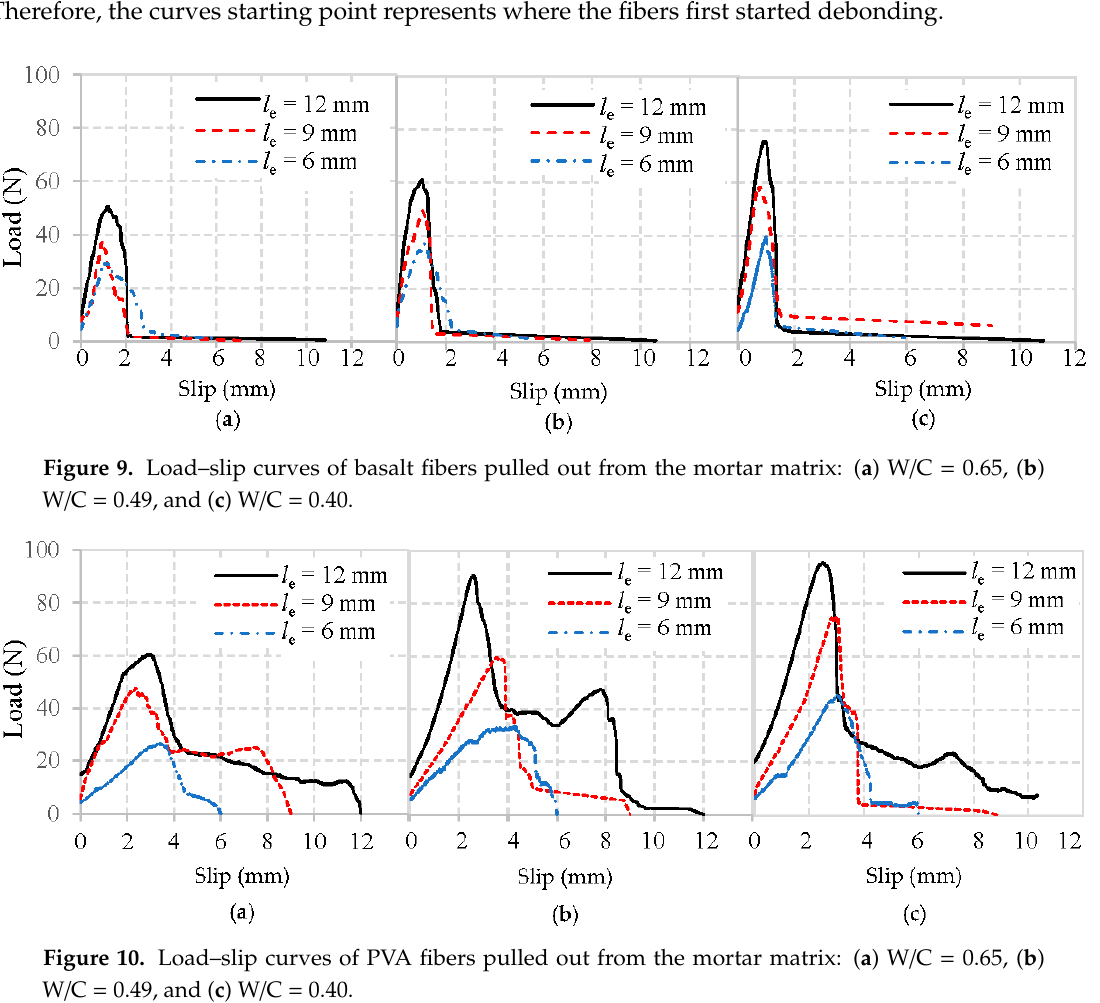
Figure 11. Load–slip curves of glass fibers pulled out from mortar matrix: ( a ) W/C = 0.65, ( b ) W/C = 0.49, and ( c ) W/C = 0.40. Obviously, all typical load–slip curves of fiber in Figures 9–11 are characterized by a rapid increase of load until the maximum load is reached, followed by a drop as the fiber is debonded. After this, only frictional resistance remains until the fiber fully pulls out of the mortar matrix. The representative values of the pullout load can be identified as the initial load that represents where the fiber debonding took place [22], and the maximum load means the fiber was completely debonded from the mortar matrix. It can first be observed in Figures 9–11 that the maximum loads show a growing trend with an increase in the fiber embedded length and the strength of mortar matrix, which has been clarified above. Moreover, the initial loads for basalt, PVA, and glass fiber from the mortar matrix presents in Figures 9–11 are significantly different. Notably, the initial load experiences an incremental change when the fiber embedment length became longer, or the mortar matrix became stronger. The main reason for the enhanced initial load is due to the larger area caused by the longer fiber and improved matrix packing density around the fiber, leading to a higher bond between the fiber and mortar matrix. Additionally, the initial stiffness obtained from the linear portion’s slope of the load–slip curve exhibits a similar trend as the initial load, which is also improved by the longer fiber embedment length and the higher strength of mortar matrix. However, with the same mortar matrix and fiber embedded length, PVA fiber always appears with a higher maximum load than either basalt fiber or glass fiber. This difference is most likely due to the highest amount of hydration products in the interface between PVA fiber and mortar [24], which can effectively improve their adhesion. Another significant difference observed in Figures 9–11 is that, after the maximum load is reached, glass fibers